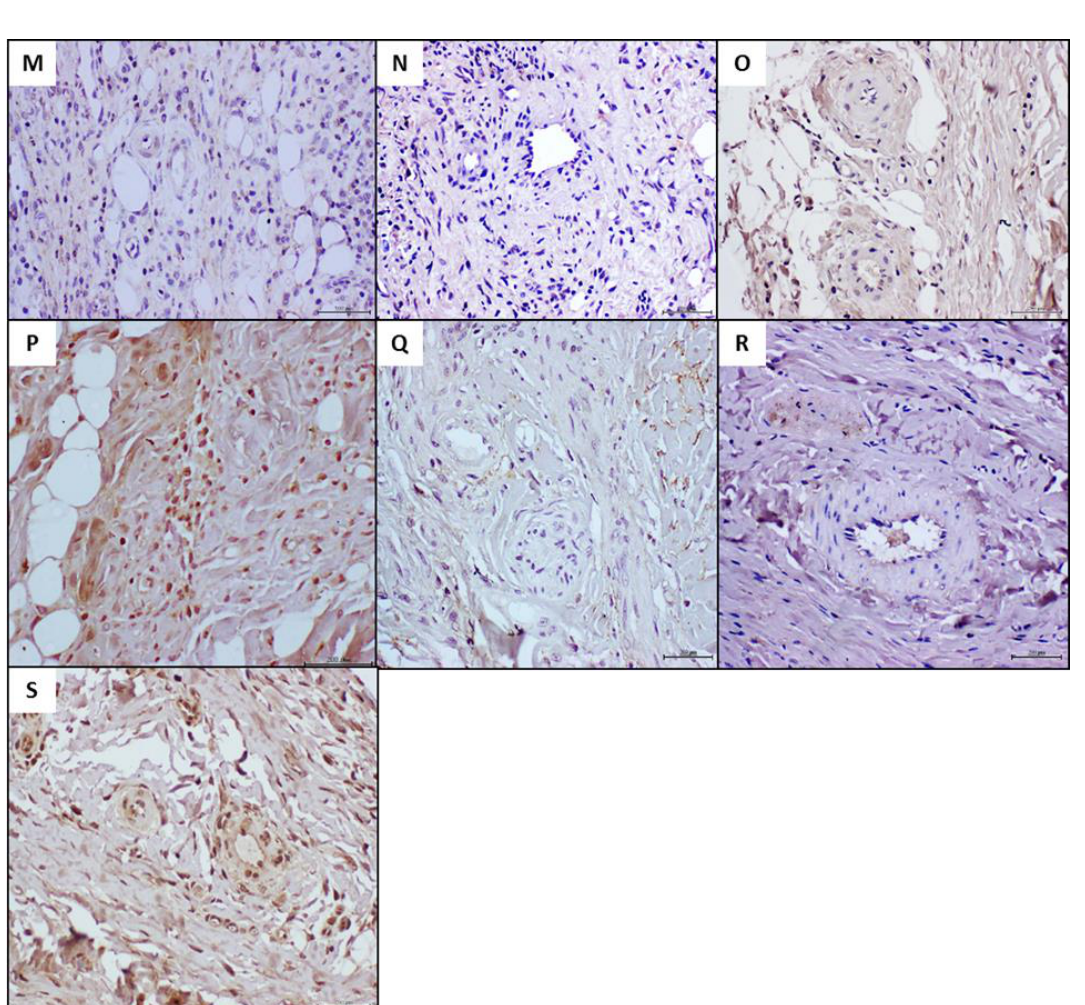
Figure 4. Immunohistological characterization of patho logic donor tissue and recipient rats’ granulation tissue with vas- cular biology-relevant antibodies. ( A ): Fragment of the arteriosclerotic popliteal artery wall showing positive signal to AGE accumulation in a transmural pattern. Similarly, the labeling to CD36 as illustrated in ( B ) is noticeable and almost transmural. ( C , D ) demonstrate no expression by granulation tissue structures of AGE and CD36 respectively, in those rats receiving the arteriosclerotic popliteal artery homogenate, which contrasts to the expression pattern found in the donor’s artery. Magnification 20×. ( E ) Demonstrates that RAGE is intensely expressed by the arteriosclerotic popliteal arterial tis- sue. Magnification 20×. ( F ): Recipient rats of the arteriosclerotic material homogenate evidently express RAGE in granula- tion tissue cells as in the vascular endothelial collar. Magnification 20×. By the contrary ( G ), no signal of RAGE expression was revealed in the granulation tissue of rats receiving the homogenate of the healthy donor brachial artery (control). Magnification 40×. ( H ): NADPH oxidase (NOX) expression is detected within an area of intramural infiltration of inflam- matory cells in the arteriosclerotic popliteal artery of the human donor. Rats treated with this pathologic material homog- enate congruently expressed strong NOX signal in perivascular infiltrated inflammatory cells as shown in ( I ), whereas the control rats treated with the normal brachial artery moderately expressed NOX in a limited number of cells adjacent to vascular walls ( J ). Magnification 20×. ( K ) demonstrates that TNF- α is intensely expressed by arterioles adjacent to the pathologic popliteal artery in the arteriosclerotic donor. The expression involves the thickened and hypercellular wall and the endothelial collar. Smaller satellite vessels also express the cytokine. Broad and strong TNF- α expression is also de- tected in granulation tissue cells and vascular structures of rats treated with the arteriosclerotic material homogenate ( L ). Of note, however, is that TNF- α expression is moderate to weak in limited cells within the granulation tissue of control rats treated with the normal brachial artery as shown in ( M ). The use of an antibody reactive to an active isoform of endothelial nitric oxide synthase (e-NOS) suggested that arteriolar pathologic remodeling is associated to the abolition of the enzyme expression as seen in ( N ), representative of the arteriosclerotic donor tissue. Interestingly, this expression deficit was also detected in the granulation tissue vessels of rats treated with the pathologic material homogenate. ( O ) illustrates that e-NOS expression is fairly marginal (moderate scoring, Table 4) in vascular cells as compared to the strong and diffuse expression found in granulation tissue samples of control rats ( P ). Magnification 40×. VEGF receptor-2